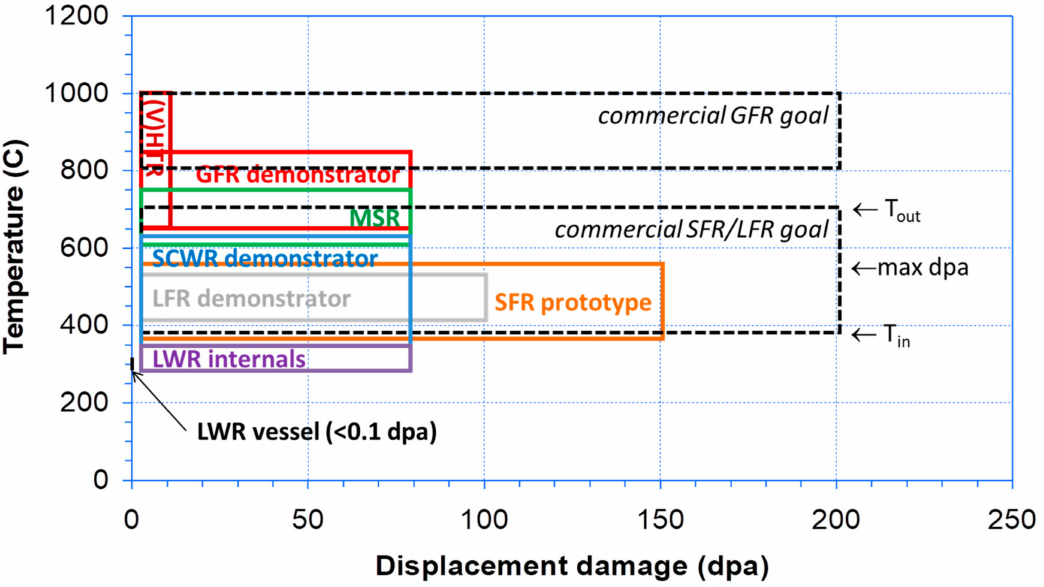
Figure 2. Schematic and indicative illustration of the operating conditions envisaged in European designs of GenIV prototypes/demonstrators, as compared to current LWRs (assuming 60 years of operation) and commercial GenIV reactors. The temperature range is defined by inlet/outlet temperatures. The maximum dpa concerns structural components. (Cf. Table 1 for